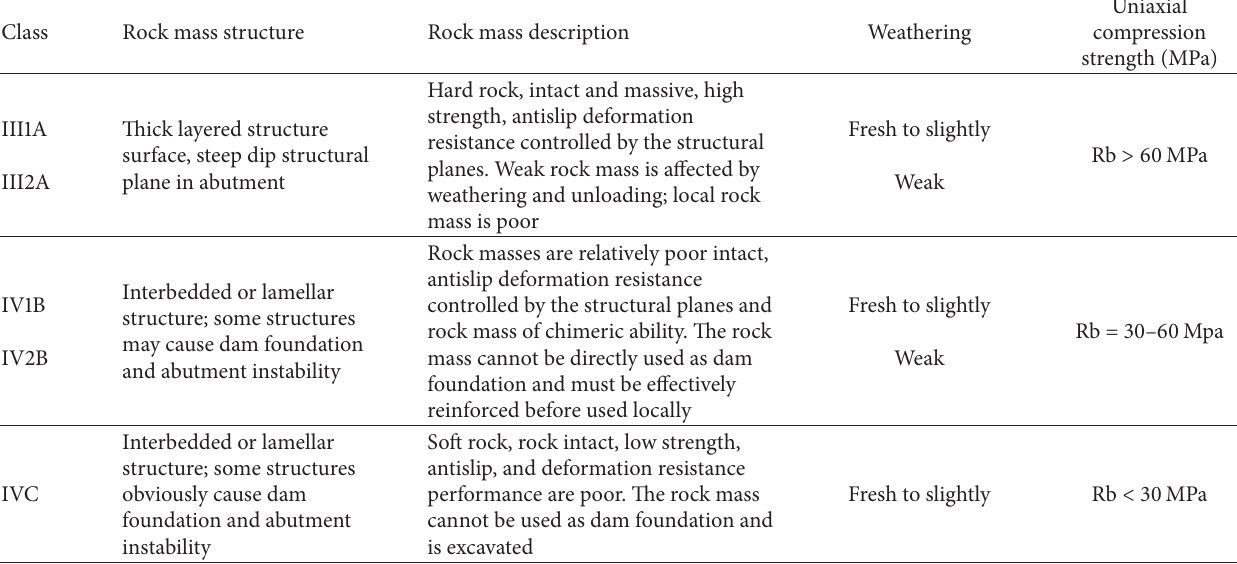
Table 2: Rock mass classification for the Guoduo dam